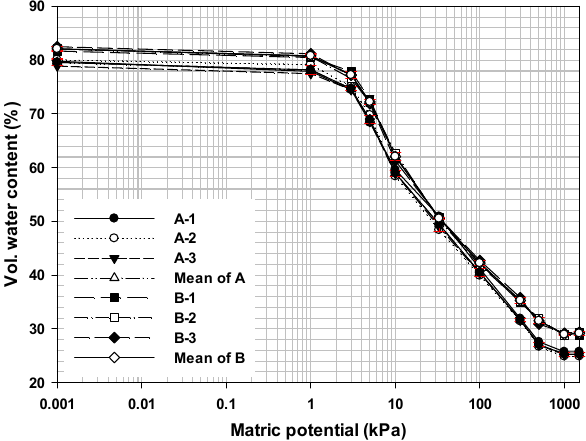
Figure 3. Water retention curves corresponding to the water potential ranging from 0 to –1500 kPa for EP A and B. A: Turkey; B: China.